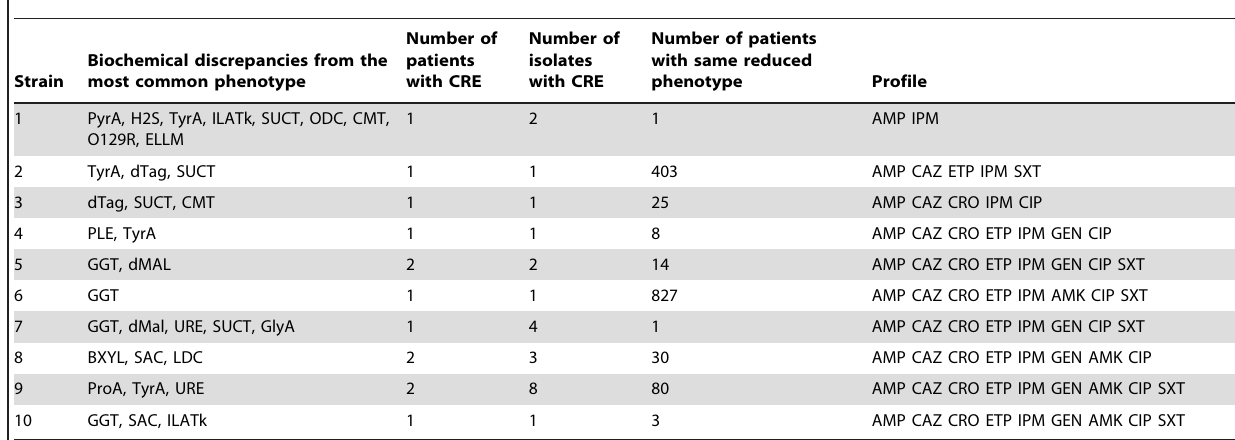
Table 5. Biochemical and resistance phenotypes of imipenem-resistant K. pneumoniae.